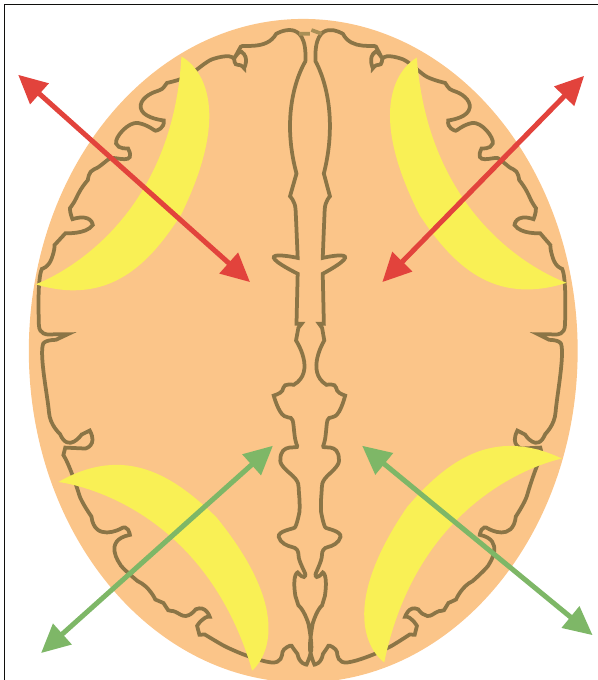
FIGURE 14: Schematic representation of the interarterial external watershed regions (depicted in yellow overlay) at the centrum ovale. The red arrows indicate the border zone between anterior cerebral artery and middle cerebral artery territories. The green arrows indicate the border zone between middle cerebral artery and posterior cerebral artery territories.